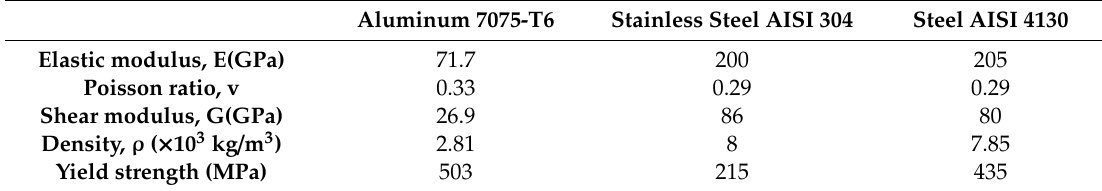
Table 4. Materials properties used in preliminary simulations.